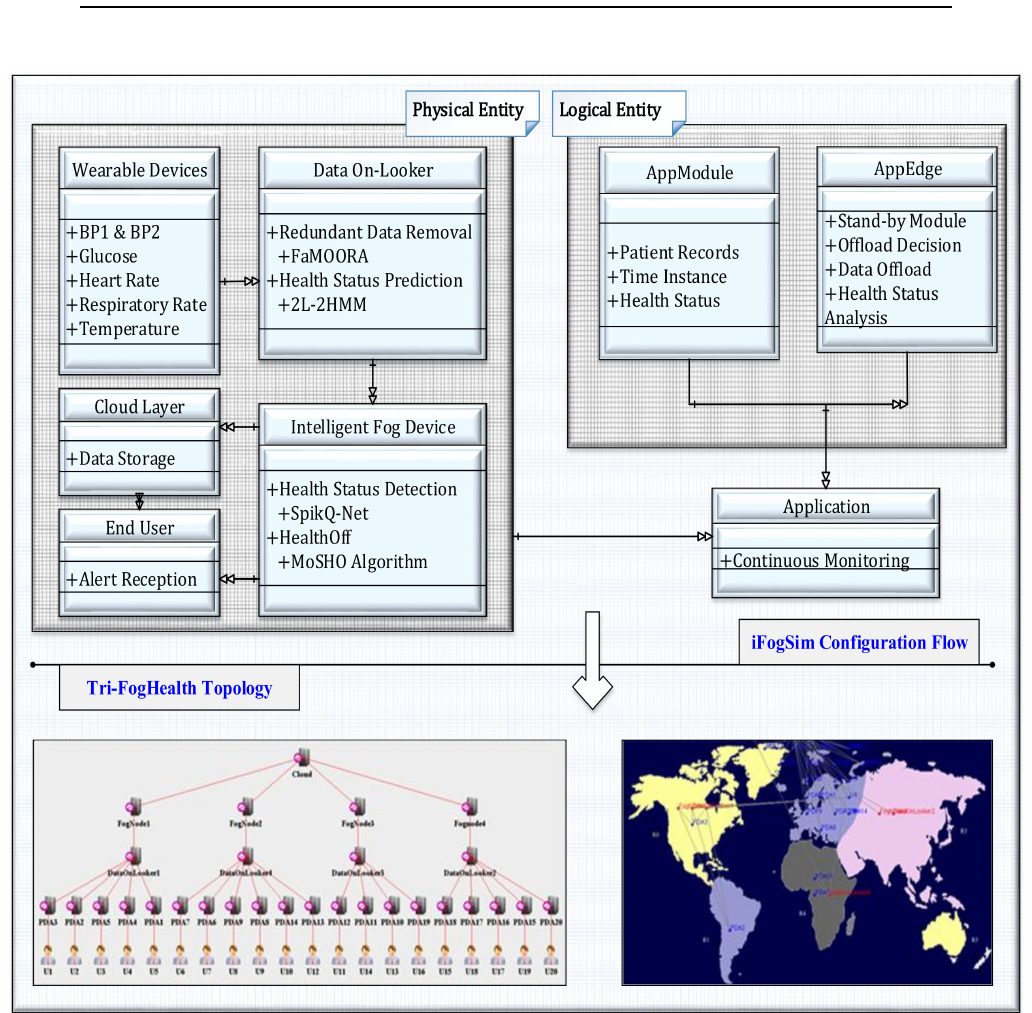
Figure 5. Experimental Setup of Tri-FogHealth